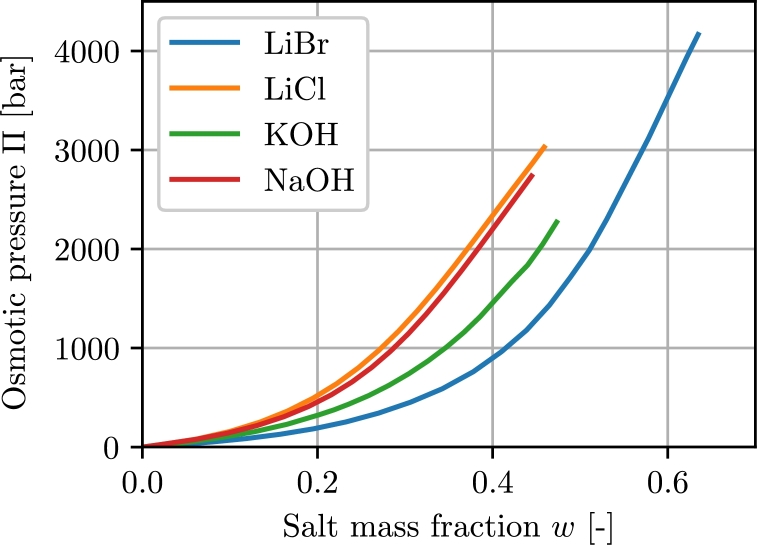
Osmotic pressures for selected absorbents at 25 ∘C. Derived from [11, pp. 395-396].